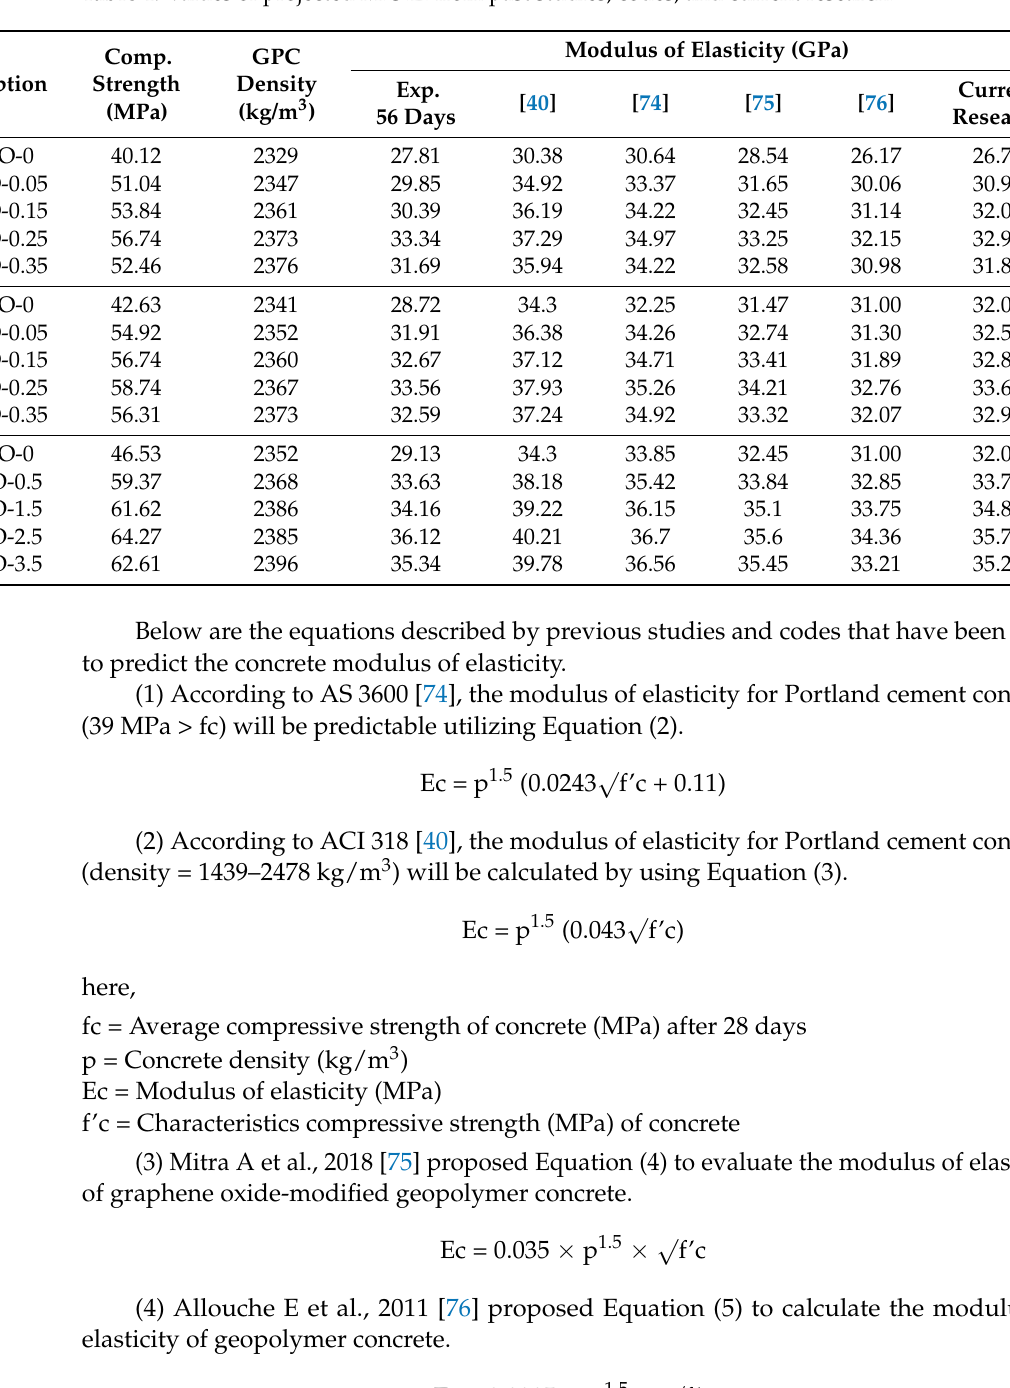
Table 4. Values of projected M.O.E. from past studies, codes, and current